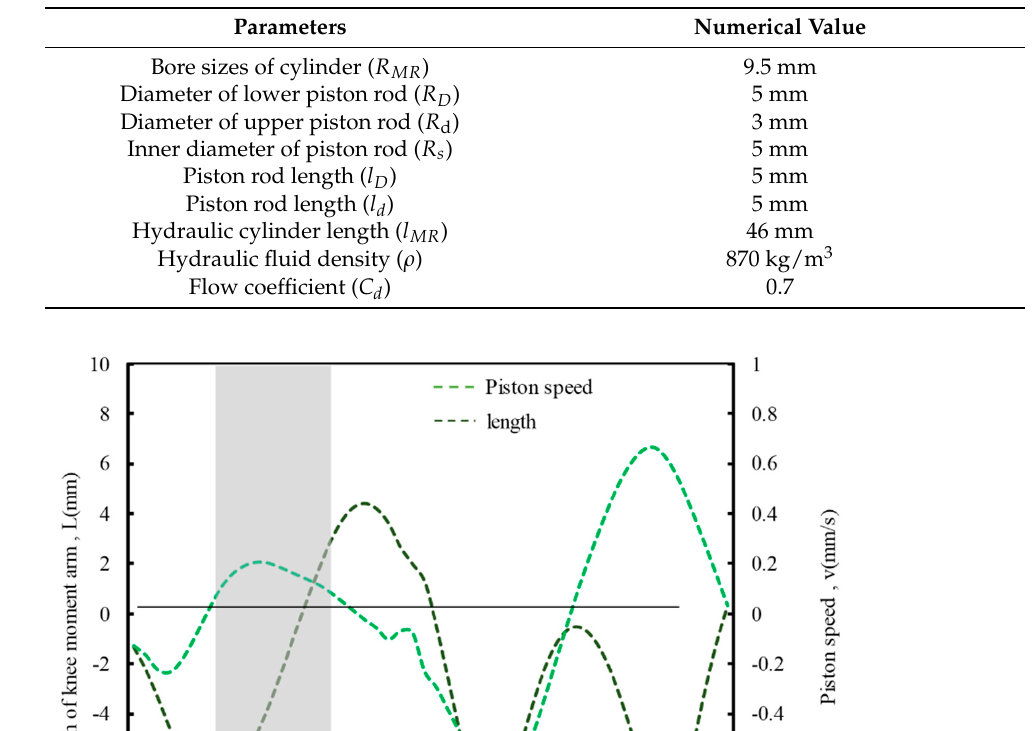
Table 1. The values of the parameters in simulation.